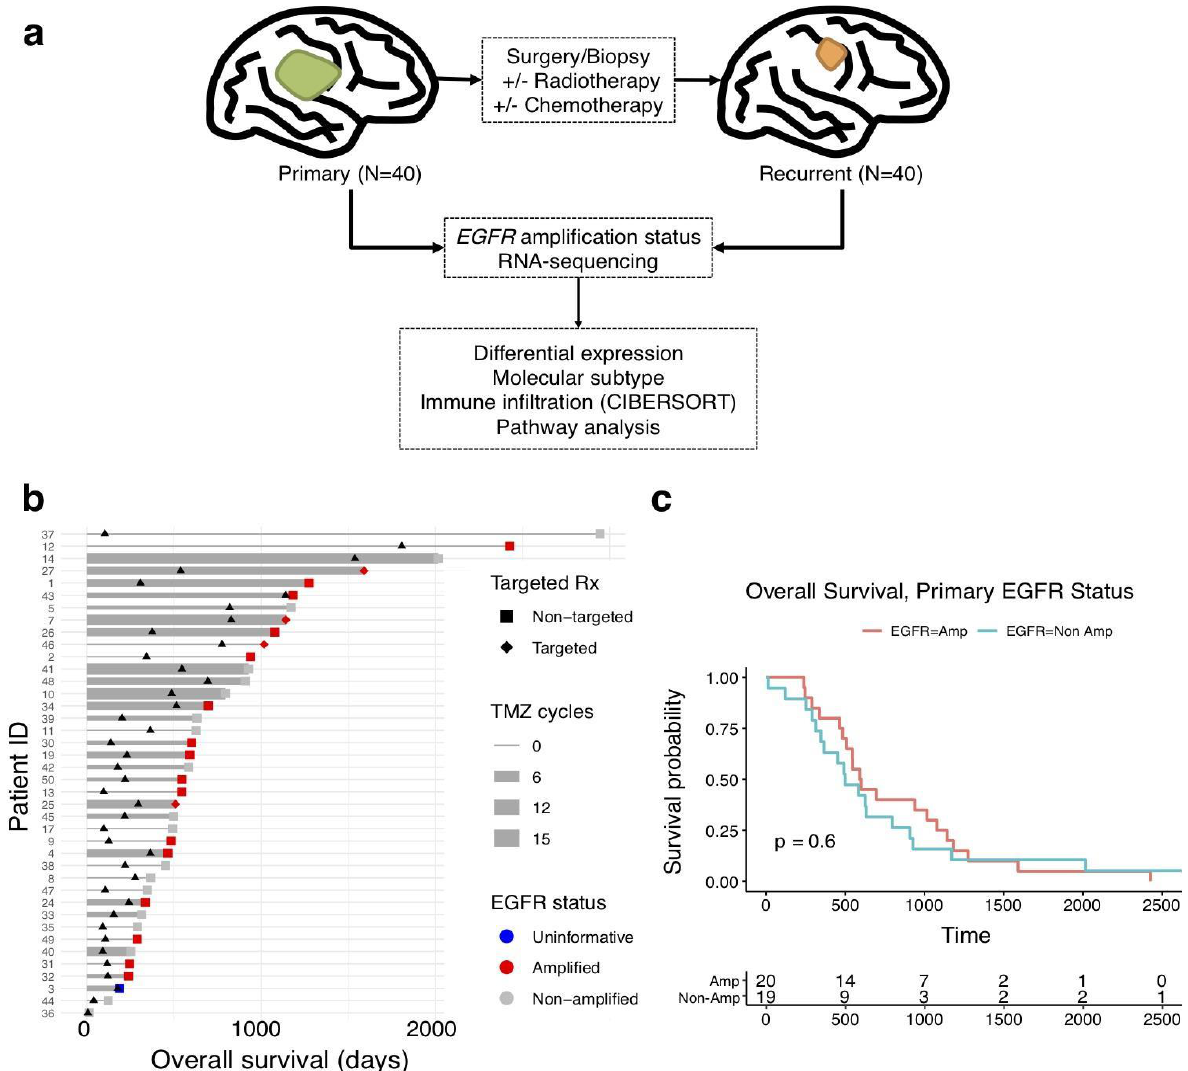
Figure 1. Study overview and participant characteristics. ( a ) Schematic illustration of study design. Samples were obtained from 40 patients with primary and recurrent glioblastoma; these were analysed by way of RNA sequencing and determination of the EGFR copy number. ( b ) The survival of the patients in the study cohort is depicted, with thicker bars indicating higher number of temozolomide (TMZ) cycles received and targeted therapy defined as small molecular inhibitors of EGFR. Triangles indicate the time of biopsy at recurrence. ( c ) Kaplan – Meier curves depicting survival between EGFR-amplified (red) and EGFR non-amplified (blue) cohorts. In our series, the presence of the EGFR amplification did not portend worse survival ( p = 0.6, log-rank test; Figure 1c; p = 0.50 after adjustment for performance status and age